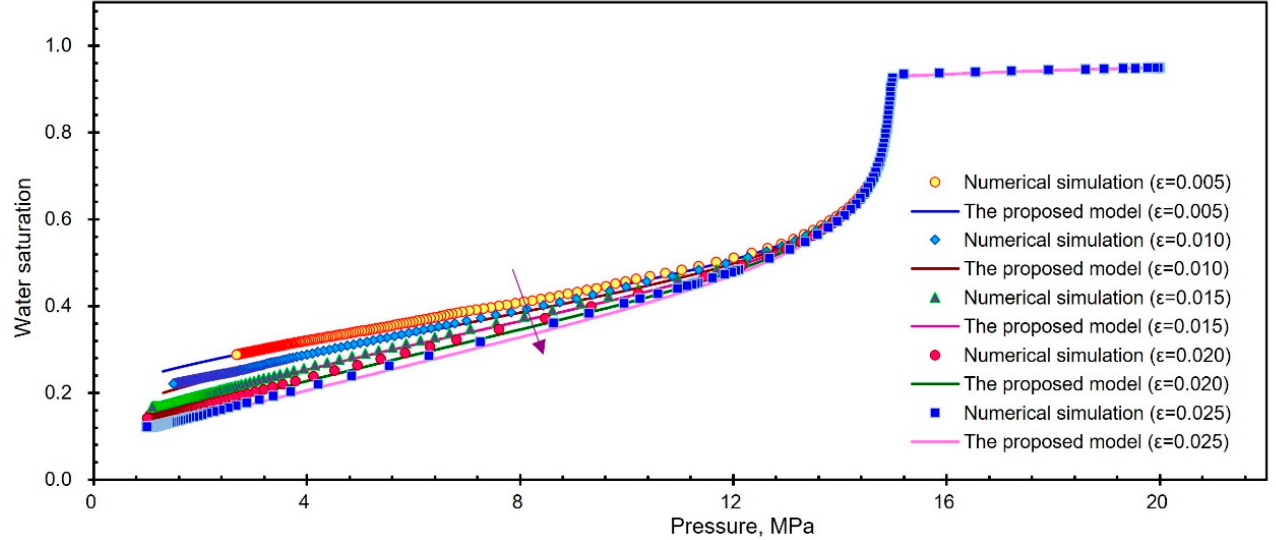
Figure 6. Comparison of calculation results of the proposed method considering different Langmuir volumetric strains.